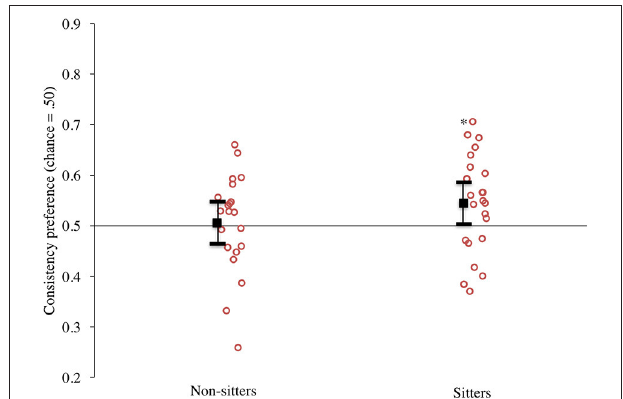
FIGURE 4 | Experiment 2 consistency preference scores by sitting status. Circles represent individual infants, solid black square represents mean responding. (Note: * denotes p < 0.05, error bars represent 95% confidence